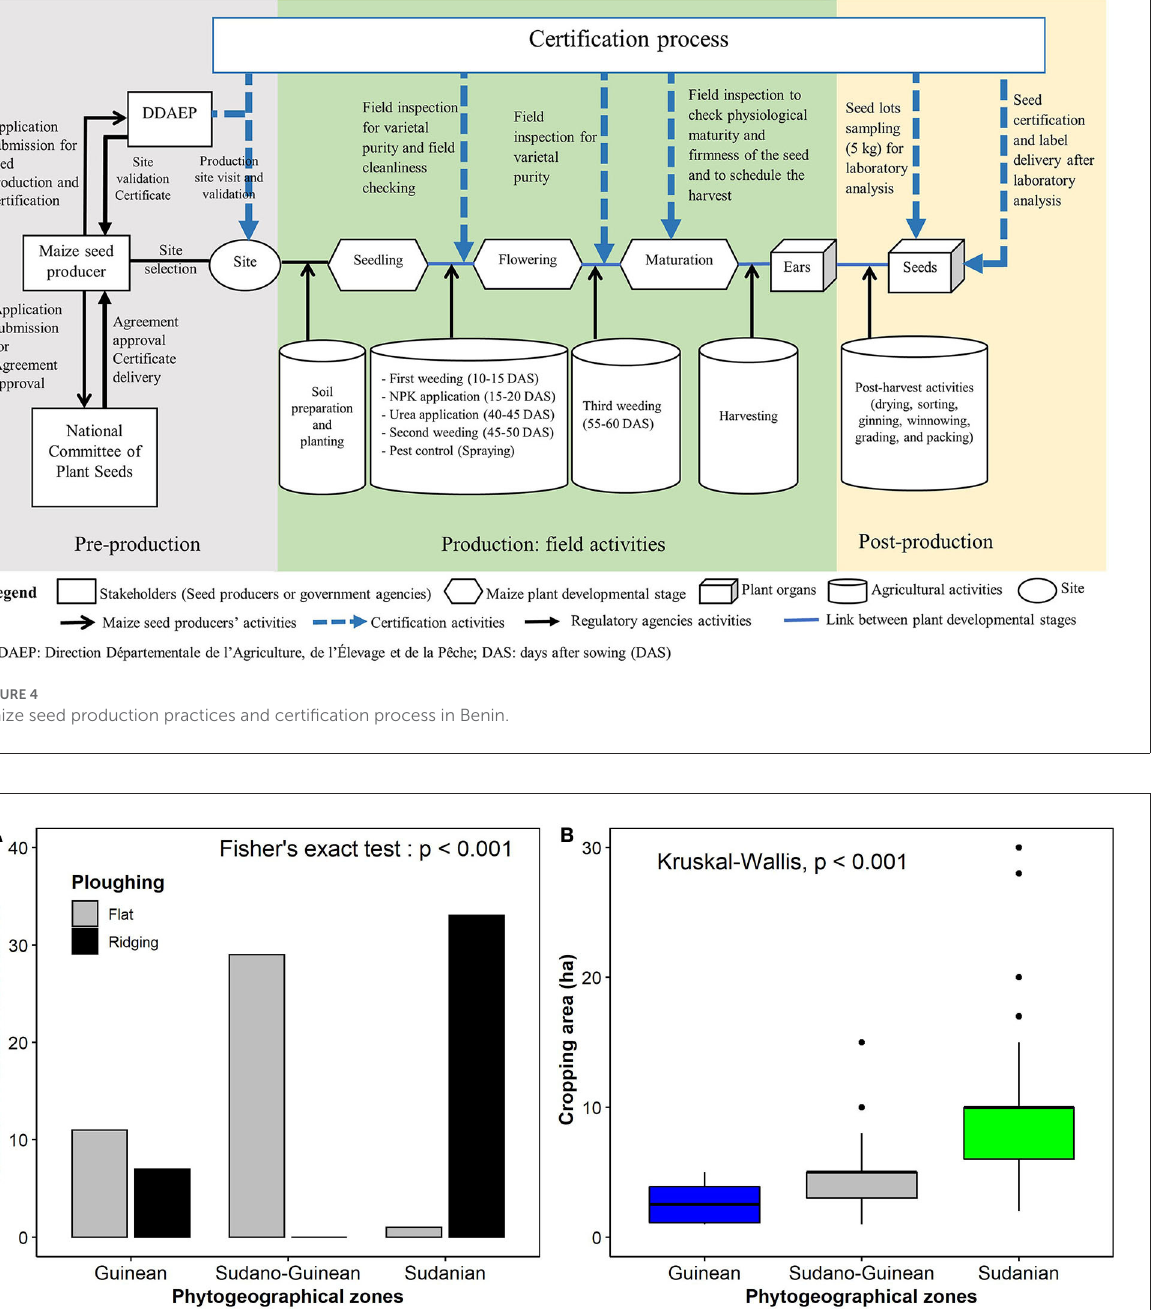
seeds, sclerotia, stones, nematode galls, and smut balls, etc.), and seeds of weeds or other cultivated species. Furthermore, pure seeds were assessed (i) visually for the presence of any other grain color, shape and (ii) by measuring seed traits